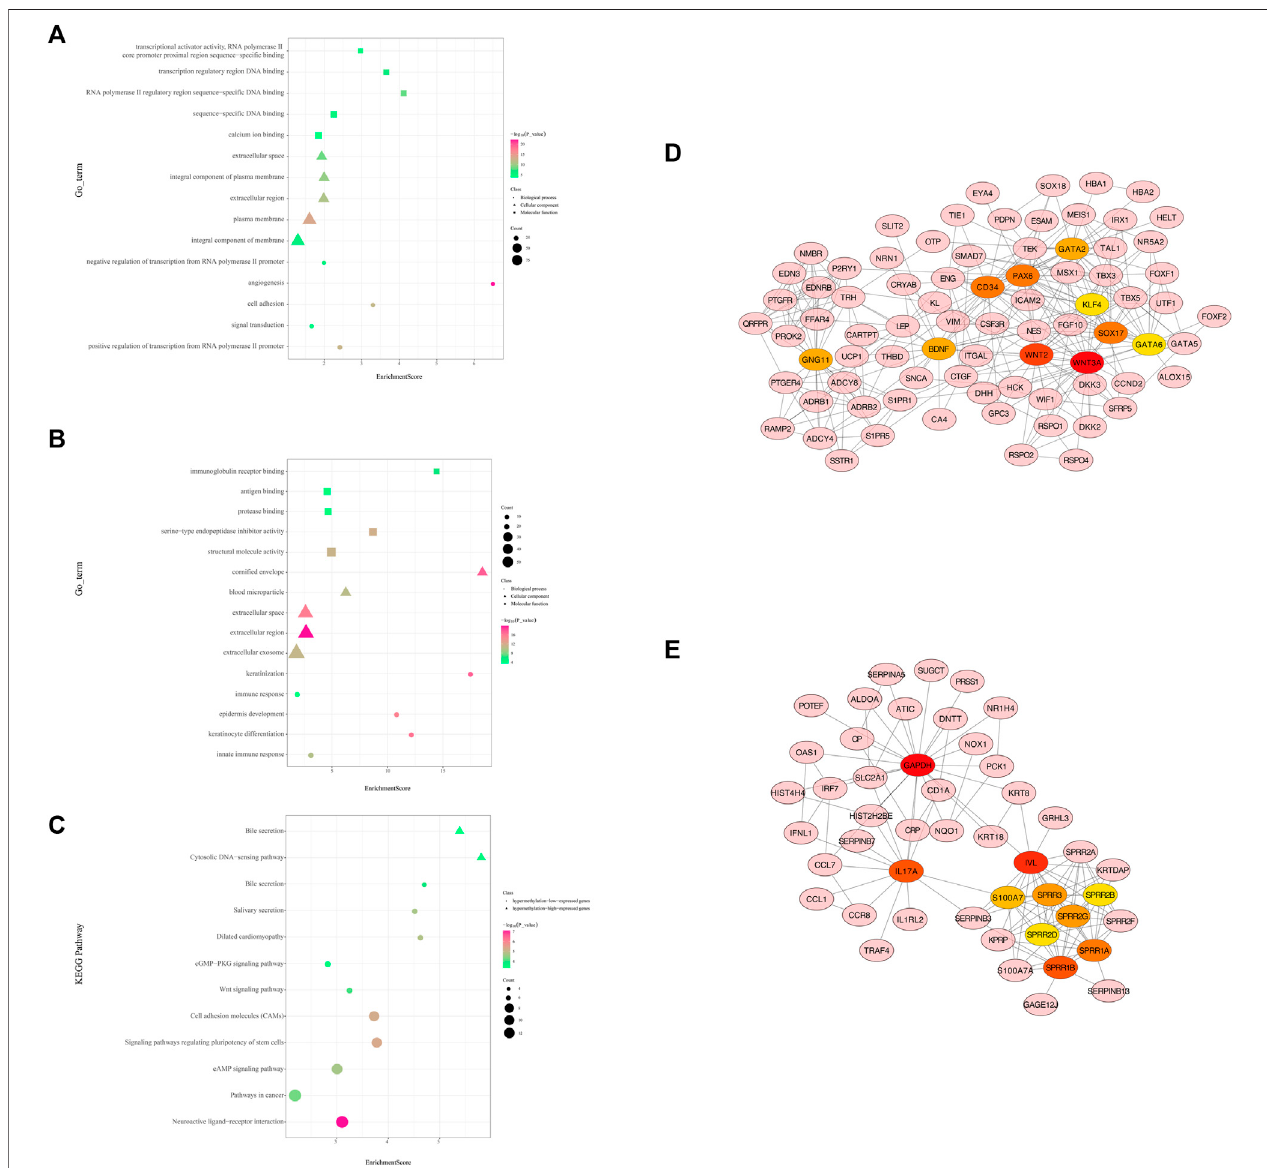
FIGURE 4 | Protein-protein interaction (PPI) network and enrichment bar graph for methylation-related DEGs. (A) Enrichment bubble graph for hypermethylated downregulated genes. (B) Enrichment bubble graph for hypomethylated upregulated genes. (C) KEGG enrichment bubble chart of hypermethylated downregulated genes and hypomethylated upregulated genes. (D) PPI network of hypermethylation and low-expression genes between cancer and adjacent samples from LUAD patients (only displays the 10 hub genes and the expanded subnetwork identi fi ed by the cytoHubba app in Cytoscape). (E) PPI network of hypomethylation and high-expression genes between cancer and adjacent samples from LUAD patients (only displays the 10 hub genes and the expanded subnetwork identi fi ed by the cytoHubba app in Cytoscape).